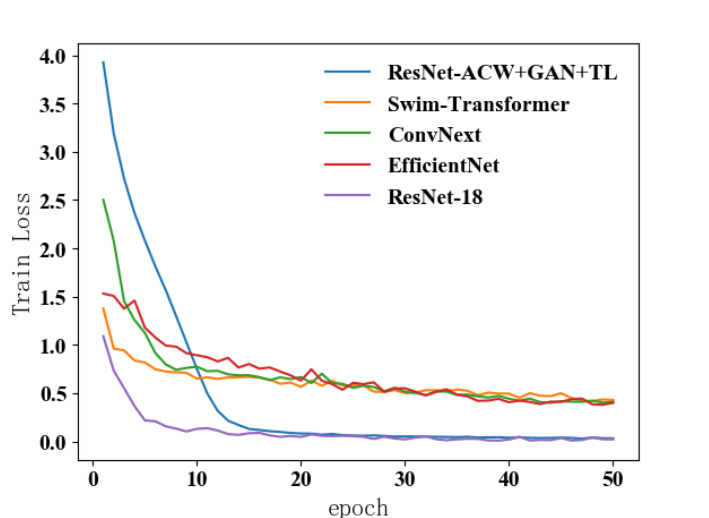
Figure 15. Val_acc curves of networks.